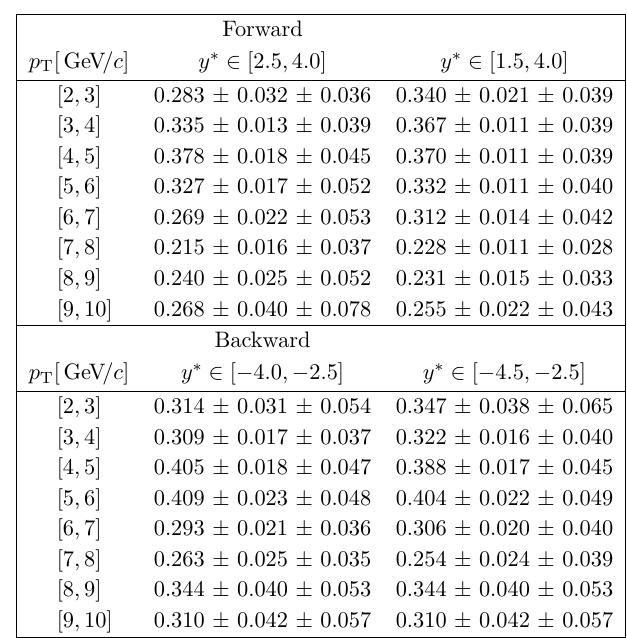
Table 7 . Production ratio R as a function of p T in the forward and backward rapidity (cid:3) + c =D 0 regions. The (cid:12)rst uncertainty is statistical and the second is systematic.